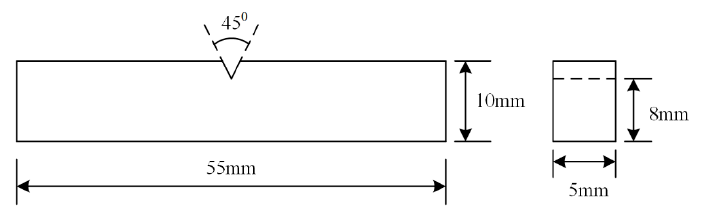
Figure 3. Dimensions of Charpy impact toughness.